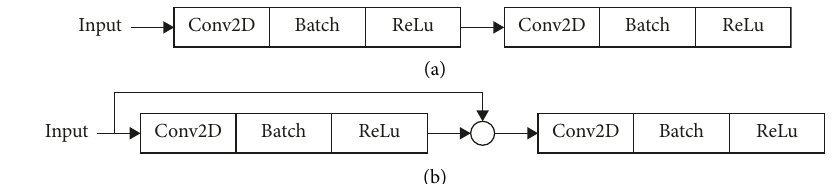
Figure 1: CNN and ResNet comparison.